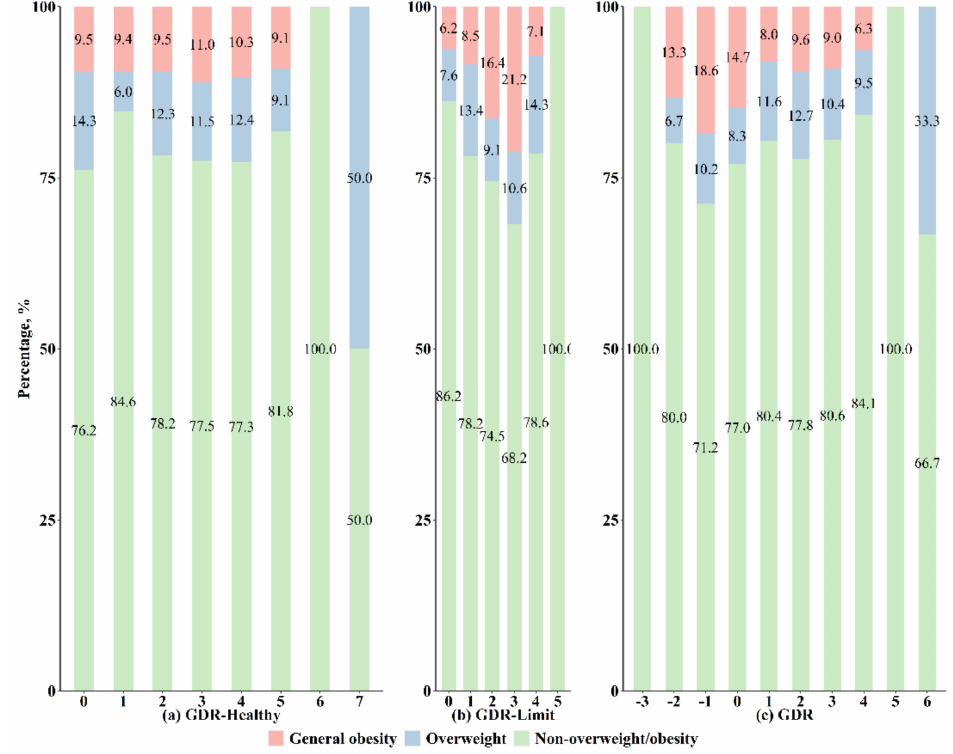
Figure 3. Prevalence of overweight and obesity by Global Dietary Recommendations (GDR)